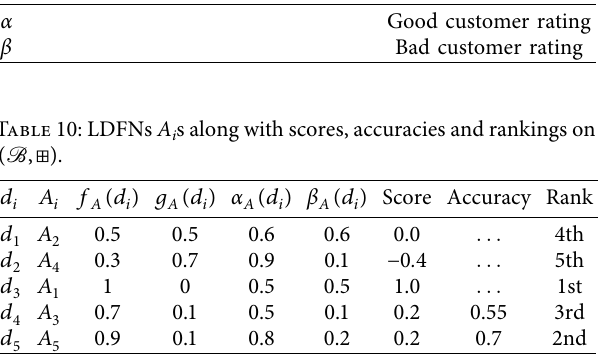
Table 9: Reference parameters α and β for chatbot selection.